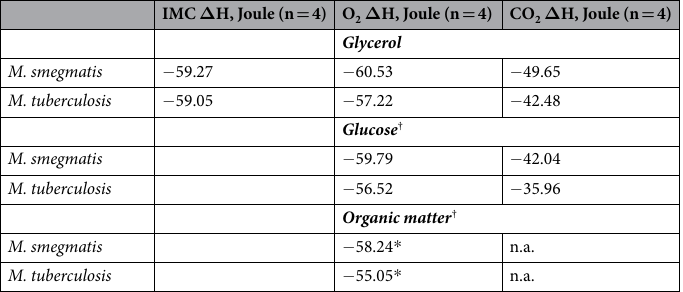
Table 2. The enthalpy change measured by IMC and calculated based on the oxygen consumption and carbon dioxide production results. * Thornton oxycaloric equivalent (i.e., 455 ± 15 KJ/mole O 2 ) is used for those calculations. † Provided for comparison purposes